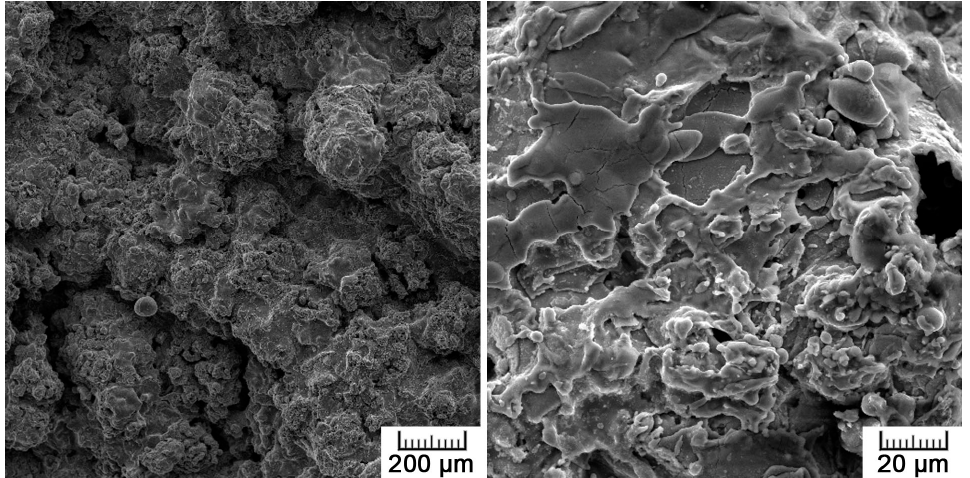
Figure 1 . Surface of plasma-sprayed titanium . Figure 1. Surface of plasma-sprayed